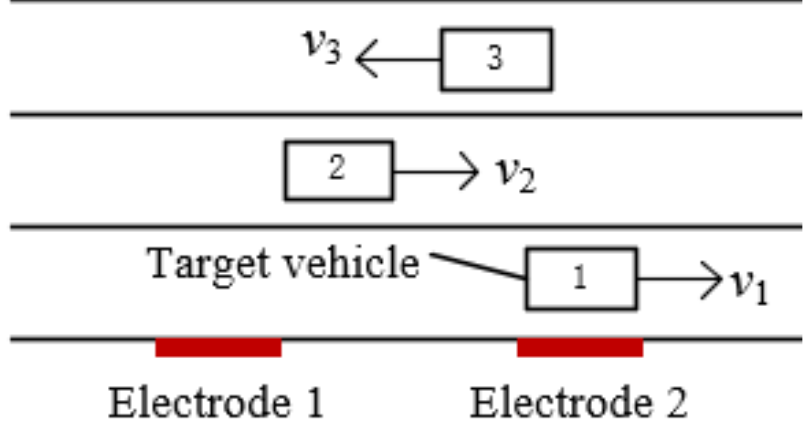
Figure 16. Diagram of multiple vehicles moving in multiple lanes.